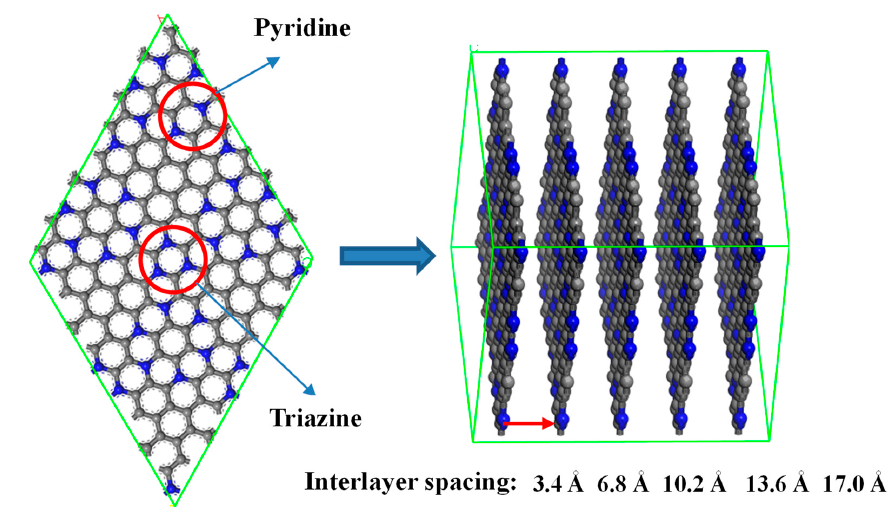
Figure 1. Initial configurations and frameworks of N-MGNs. Table 1. Lennard-Jones parameters and atomic partial charges for CO 2 , N 2 , and N-MGNs.